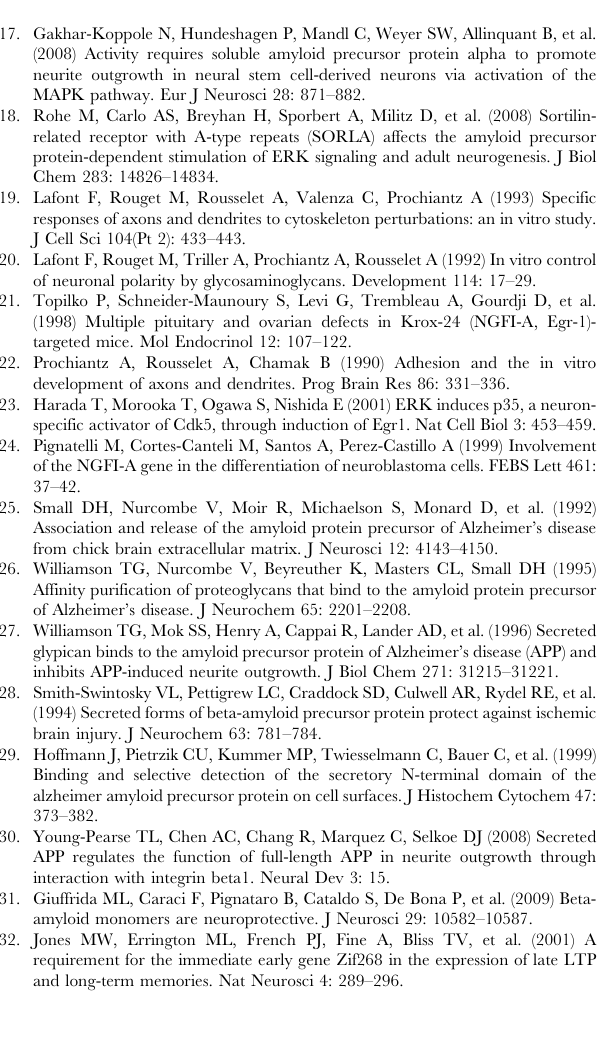
Table S2 Presentations of parameters investigated in Figure 5. In Figure 5, 150 nM sAPP-Fc or sAPP b were added to 1DIV embryonic cortical neurons from wild type (WT), heterozy- gous (HT), homozygous (KO) neurons from Egr1 (C57Bl/6J background) mutant mice. Morphometric analysis was performed 96 hours later. The data are expressed as Mean 6 S.E.M. The levels of significance are indicated by a star and detailed in the legend of Fig. 5.